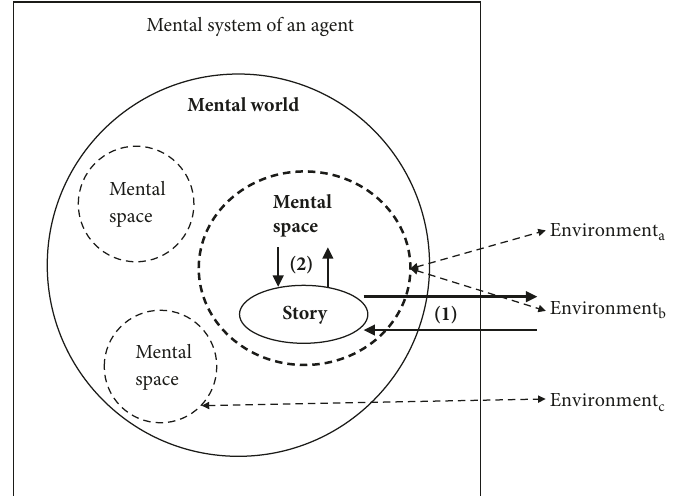
Figure 2: Two dynamic aspects of a mental world: (1) the generation of a story and (2) development of the organizational structure of a mental world.